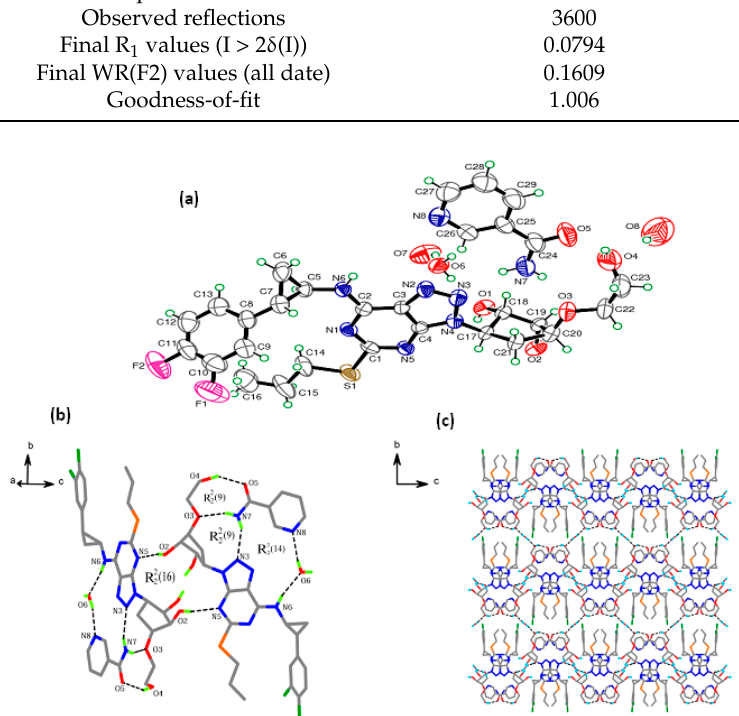
Figure 1. The crystal structure of TICA-NCA hydrate ( a ) ORTEP diagram with 50% probability, ( b ) Hydrogen bonding connection diagram, and ( c ) crystal packing along bc direction. ( b ) Hydrogen bonding connection diagram, and ( c ) crystal packing along bc